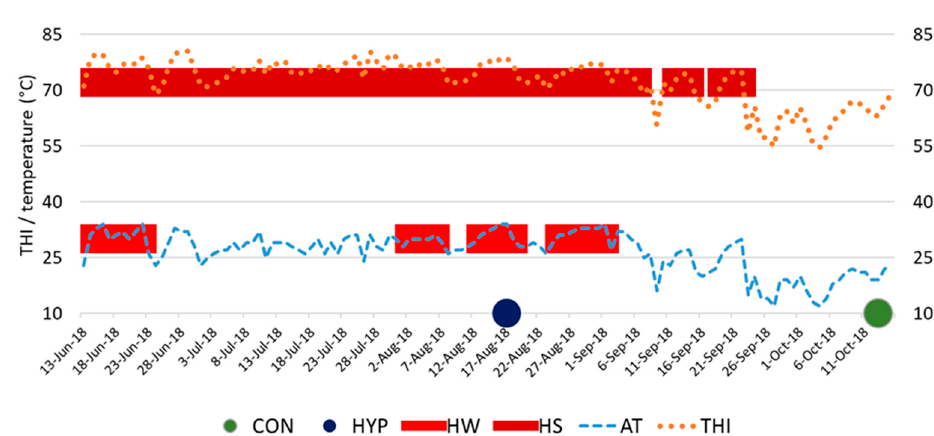
Figure 1. Environmental parameters during the experimental period. CON, control group of animals; HYP, group of animals in conditions of hyperthermia; HW, heat wave; HS, heat stress; AT, air temperature; THI, temperature-humidity index.